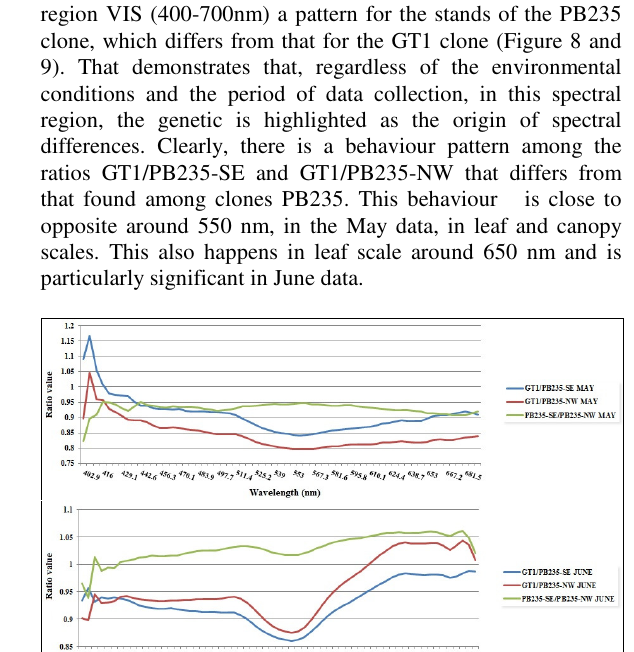
Figure 5. Spectral behaviour in leaf scale from 450 to 480nm, for May and June, of the Rubber trees stands: GT1, PB235-SE Figure 8. Ratios among spectra of the Rubber trees stands (GT1, and PB235-NW PB235-SE and PB235-NW) from 400-700nm for May and June, in canopy scale